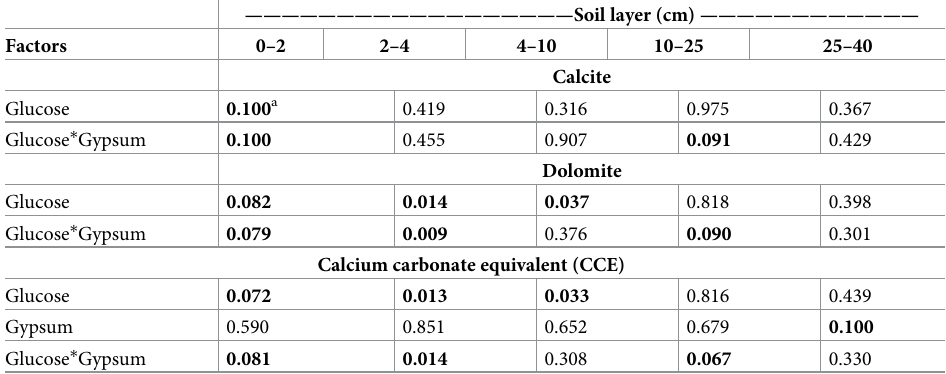
Table 4. Probability values of significant factors on inorganic C fractions in Hoytville soils in different soil